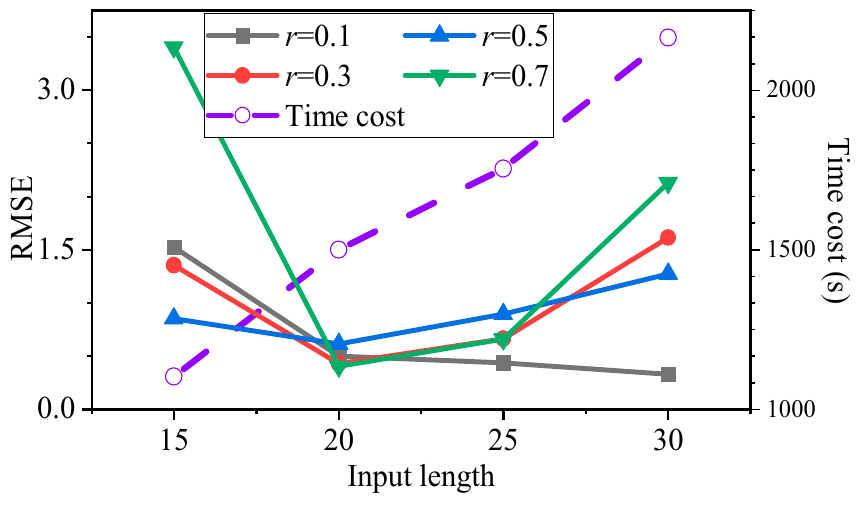
Figure 20. RMSEs of different input lengths.